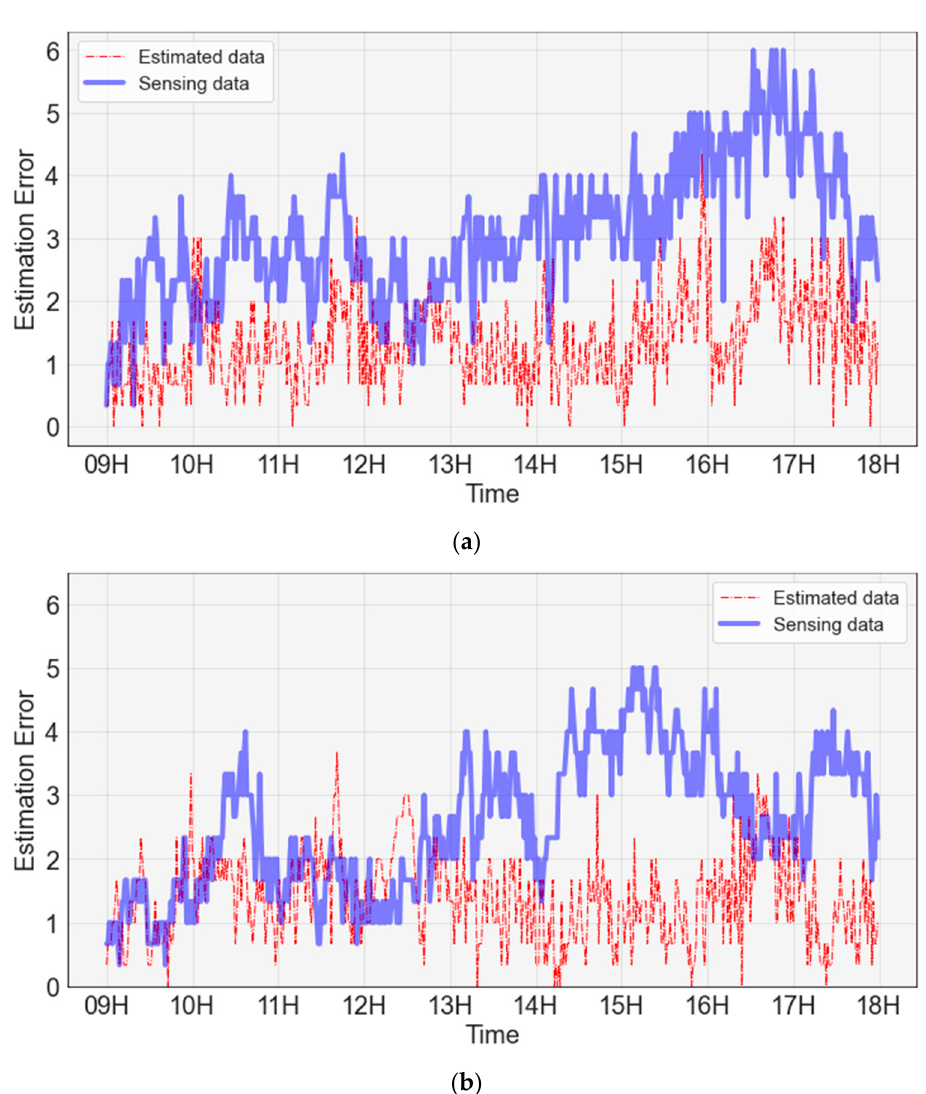
Figure 12. Analysis of occupancy error by time zone between sensing and estimated data: ( a ) average measurement error in room 1; ( b ) average measurement error in room 2.